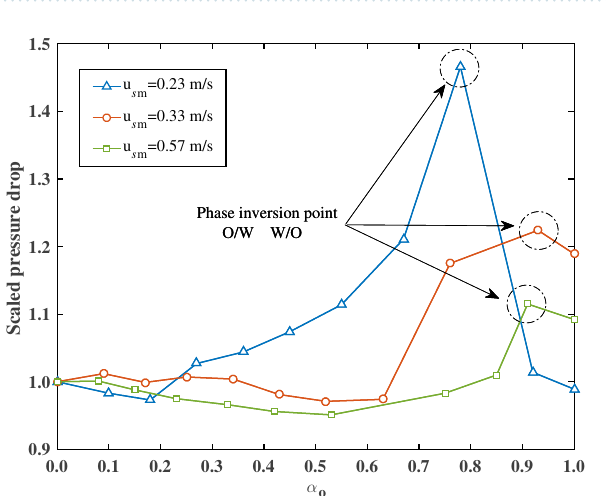
Figure 5. Typical evolution of the cross-sectional average water holdup α w and PDF for oil–water pipe flow: dispersion of water in oil ( u s w = 0.02 m/s, u s o = 0.20 m/s).